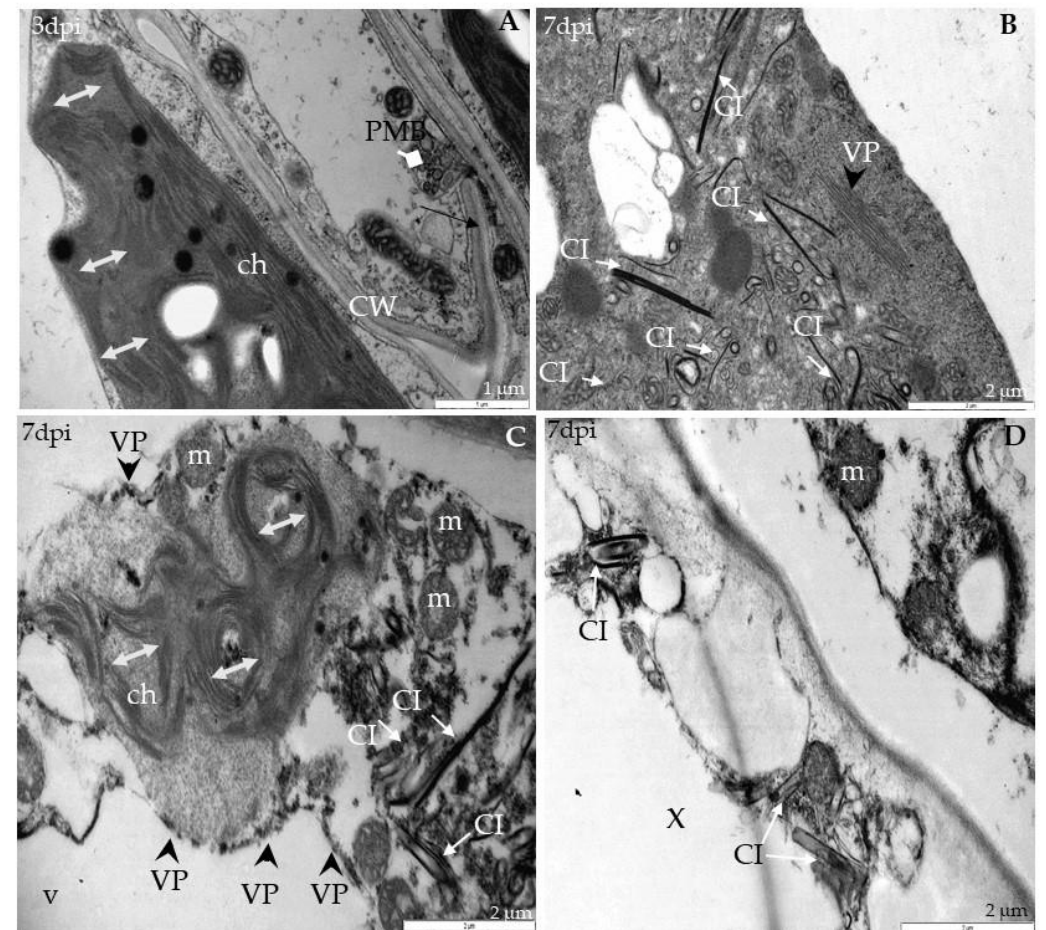
Figure 3. Virus particles and viral cytoplasmatic inclusion, changes in chloroplast lamellae stacks in rbohD plants leaf tissues 3 ( A ) and 7 days (B – D ) after TuMV inoculation examined under TEM. ( A ) Curved (double-headed arrow) chloroplast (ch) thylakoids, cell wall (CW) invagination (black arrow) and paramular bodies (PMBs; marked by diamond head arrow) in palisade mesophyll cell. ( B ) Virus particles (VPs, with arrowhead) and virus cytoplasmic inclusions (CIs; arrows) in palisade mesophyll cell. ( C ) Destroyed chloroplast (ch) with disorganized thylakoids (double-headed arrow), virus cytoplasmic inclusions (CIs; white arrow) and viral particles (VPs; black arrowhead) in cytoplasm of spongy mesophyll cell. v—vacuole; m—mitochondrion. ( D ) Virus inclusions (CI; arrow) inside xylem tracheary elements (X). m—mitochondrion.